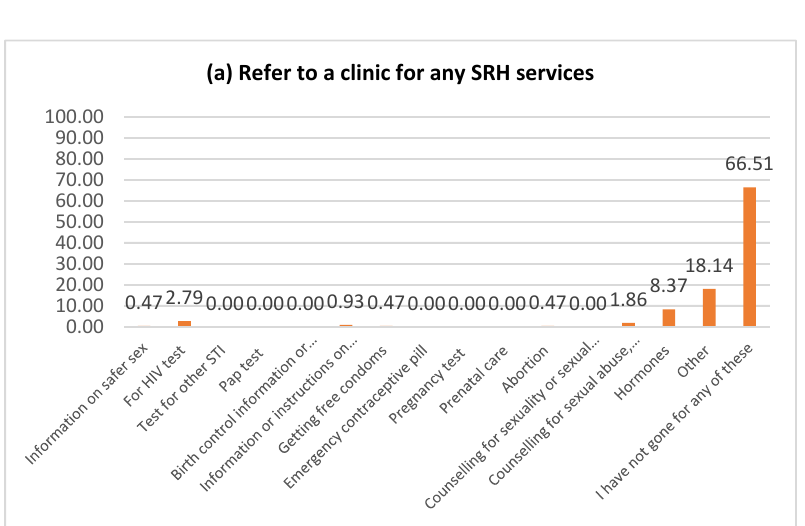
Figure 1. Adolescents Sexual and Reproductive Health Information.